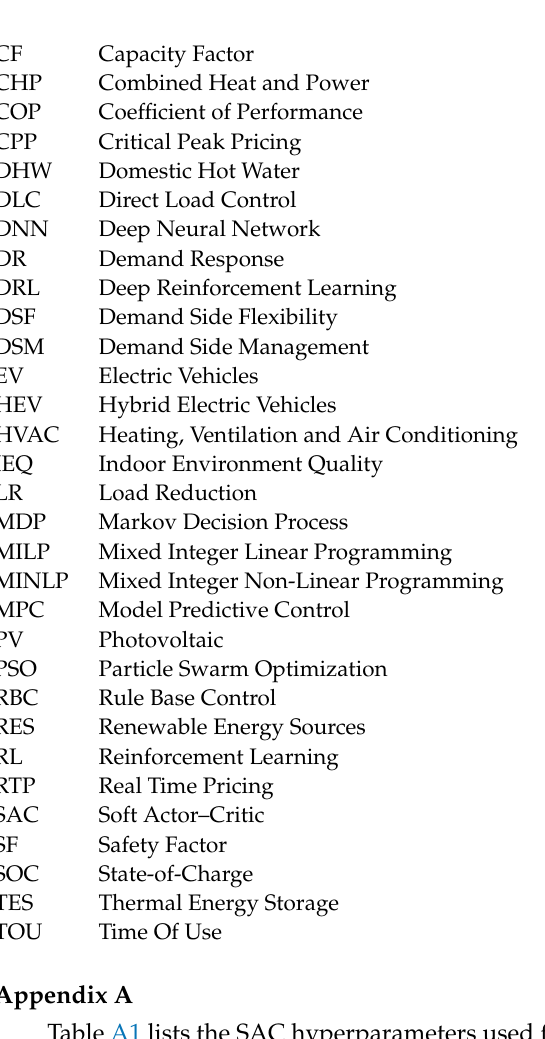
Table A1 lists the SAC hyperparameters used for the DRL and hybrid-DRL controllers. Table A1. Settings of the DRL controllers